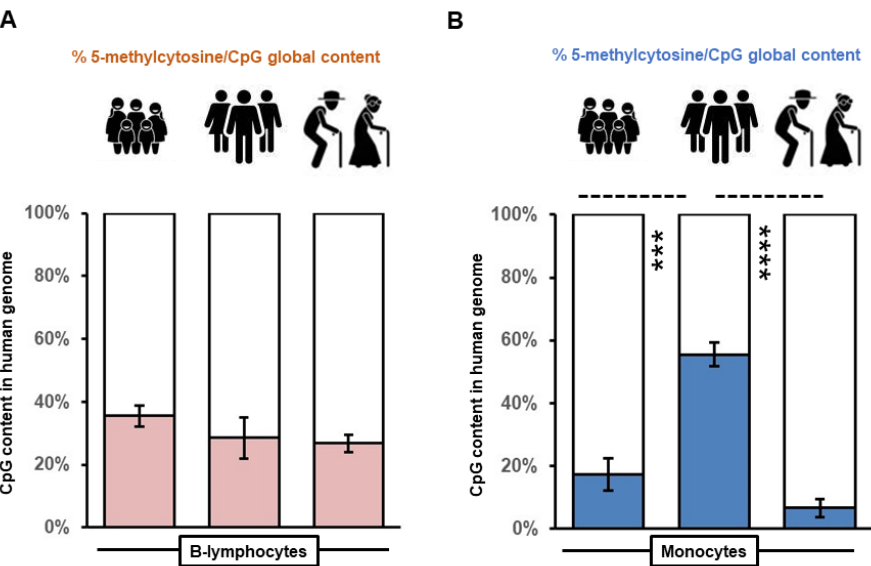
Figure 1. Monocytes reveal variation in global methylation of genomic DNA across age groups as determined from long interspersed nucleotide element 1 ( LINE-1 ) repeats. Histograms representing the percentage of 5-methylcytosine per CpG islands of retro-transposable LINE-1 sequences within B-lymphocytes ( A ) and monocytes ( B ) extracted from children, adults, and senior individuals ( n = 6 per group). Mean values are shown within the histogram rectangle with standard error bars indicative of variation between individuals. Asterisks represent significant comparative differences between groups indicated with dashed lines (*** p = 0.0003; **** p = 6.5 × 10 − 5 ).